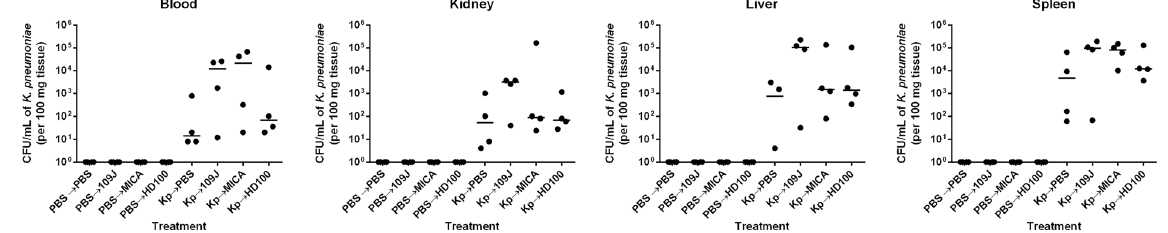
Figure 6. K. pneumoniae bacterial burden within rat blood and organs after treatment scheme #2 with predatory bacteria. K. pneumoniae (or PBS for control groups) was initially introduced into rats via intravenous inoculation. Animals were then treated via tail vein injection with PBS, B. bacteriovorus 109J, HD100, or M. aeruginosavorus (MICA) at 30 minutes, 5, 9.5, and 14 hours post-injection. At 16 hours, blood was collected and kidneys, livers, and spleens were harvested, homogenized, and plated on MacConkey agar plates to recover K. pneumoniae CFUs. Four rats per treatment group were used at each time point. Each data point represents a single rat’s respective bacterial load. Horizontal lines represent the median of the results from each treatment set. Significant differences between treatment groups and respective control were performed using the Mann- Whitney